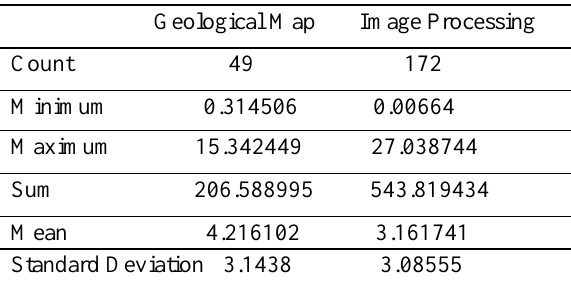
Table 1. Comparisons between the lineament extraction from geological map and from the image processing.